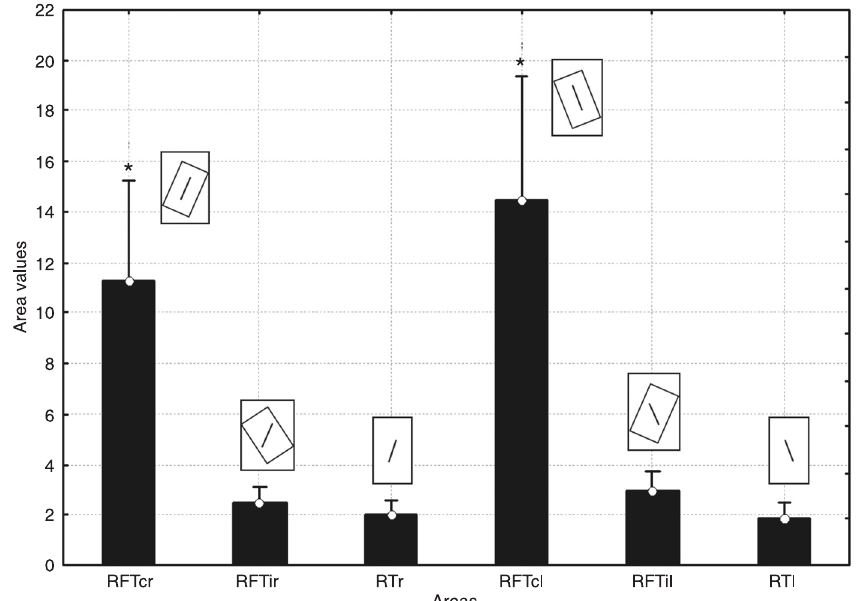
Figure 2. Area under the curve obtained in the rod test (RT) and rod and frame test (RFT). RFT congruent situations (RFTcl and RFTcr) differed significantly from both incongruent situations (RFTil and RFTir) and RTl and RTr; l = left; r = right (repeated measures ANOVA, post hoc Tukey test, P < 0.01).